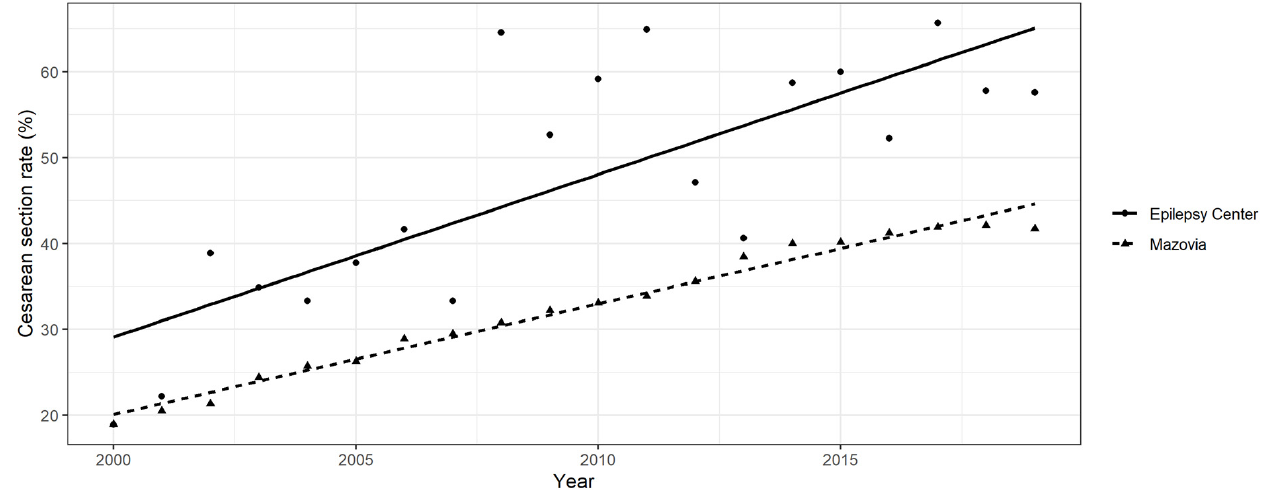
Figure 1. Linear regression of caesarean section rate by year for patients in the epilepsy centre (WWE) and the general population of Mazovia County.